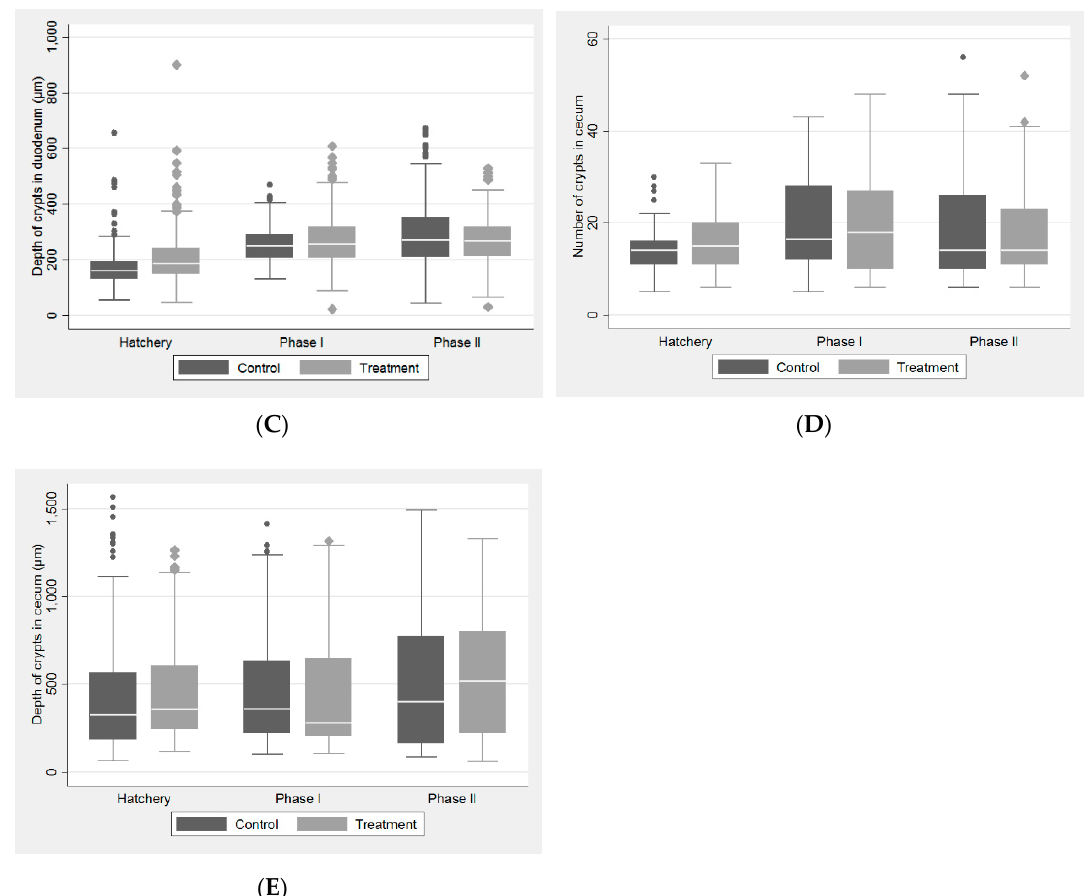
Figure 1. Graphs showing changes in histomorphometric parameters of the duodenal and the cecal mucosa from hatchery to phases I and II: ( A ) number of villi in the duodenum was significantly increased in phase I in the FDA-supplemented group (treatment); ( B ) height of villi in the duodenum was significantly increased in the hatchery in the FDA-supplemented group (treatment); ( C ) depth of crypts in the duodenum was significantly increased in the hatchery in the FDA-supplemented group (treatment); ( D ) number of crypts in the cecum: no significant differences were observed between the control and treatment group; ( E ) depth of crypts in the cecum was significantly increased in the hatchery and phase I in the FDA-supplemented group (treatment).